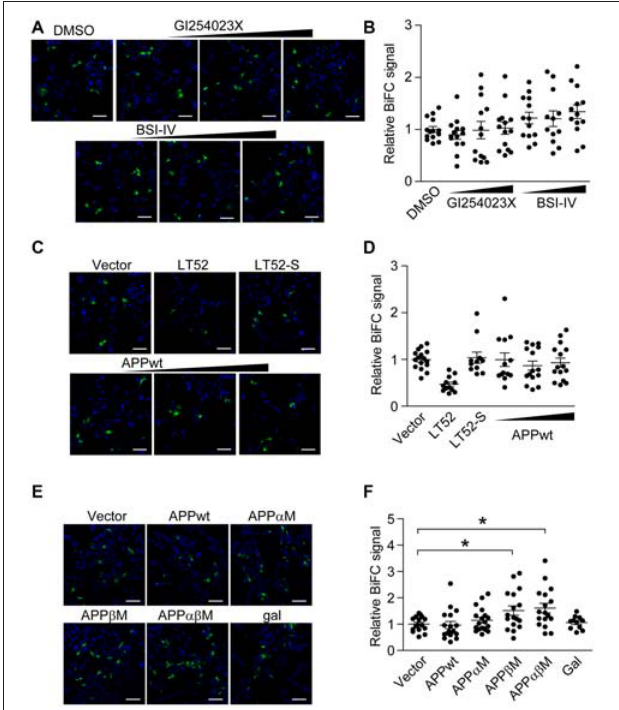
FIGURE 2 | Amyloid- β precursor protein (APP) α -/ β - cleavage sites mutant enhances BiFC signal of α -/ β -secretase. (A,B) Secretases inhibitors do not affect ADAM10/BACE1 BiFC signal. HEK 293 cells were transfected with ADAM10-CV and BACE1-NV for 8 h, and treated with 0.3 µ M or 1 µ M or 3 µ M α -secretase inhibitor GI254023X, or treated with 0.1 µ M or 0.3 µ M or 1 µ M β -secretase inhibitor BSI-IV. Eight hours after treatment, cells were fixed for BiFC detection (A) scale bar: 100 µ m. (B) Treatment with GI254023X or BSI-IV showed little effect on ADAM10/BACE1 BiFC signal. Images under 20